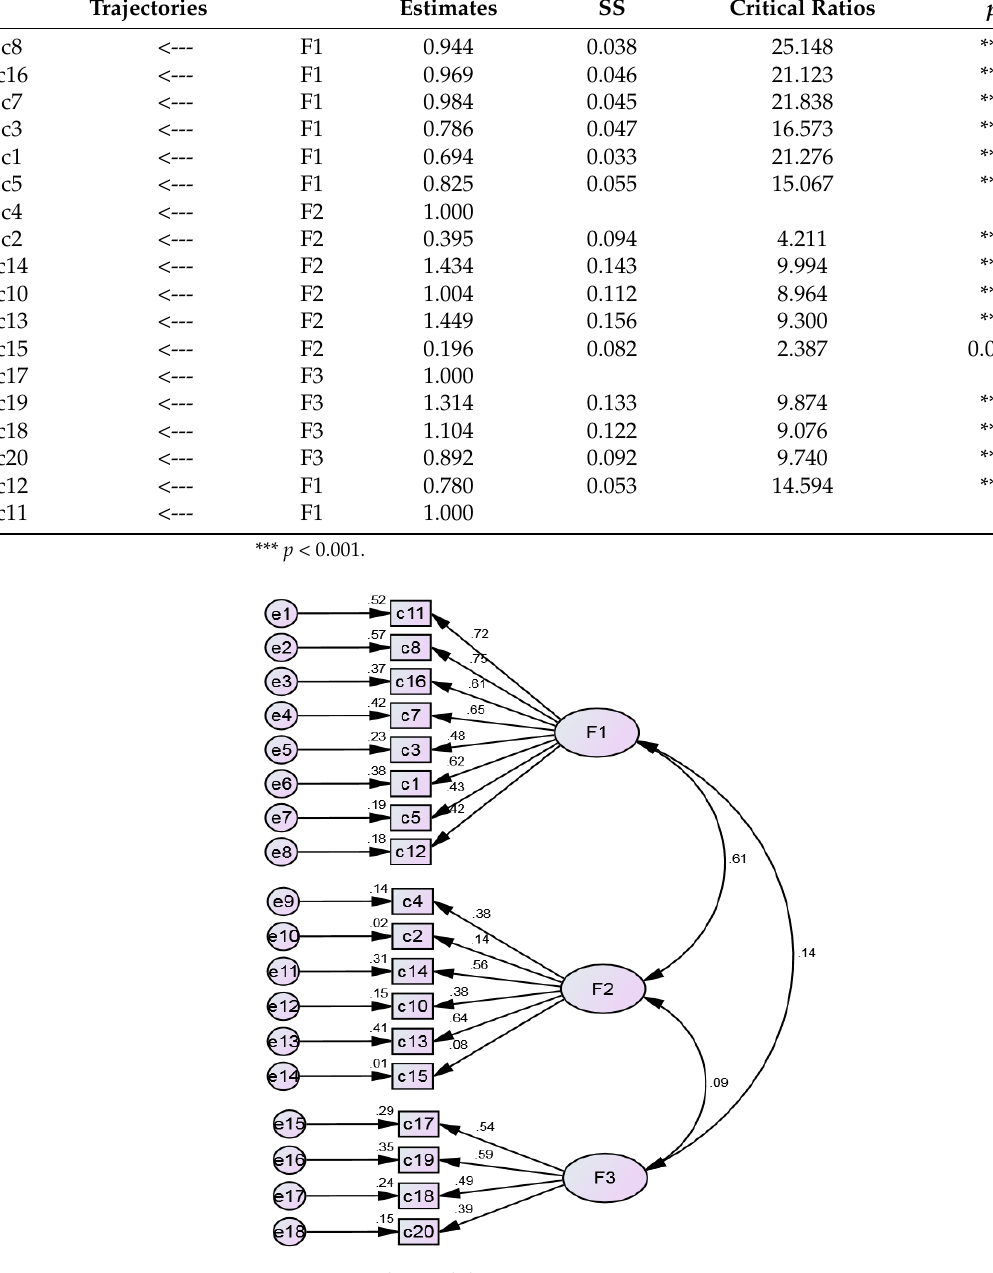
Figure 3. Final refined model with modification indices.